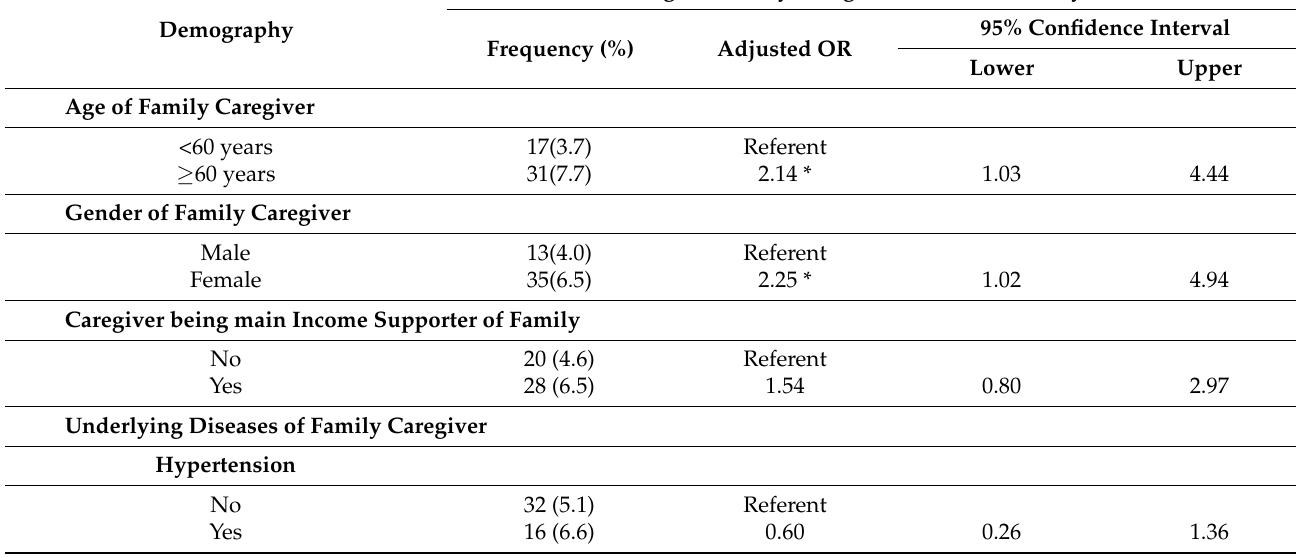
Table 3. Factors affecting the family caregiver burden, indicating the needs for respite care, Maehia subdistrict, Chiang Mai, Thailand,